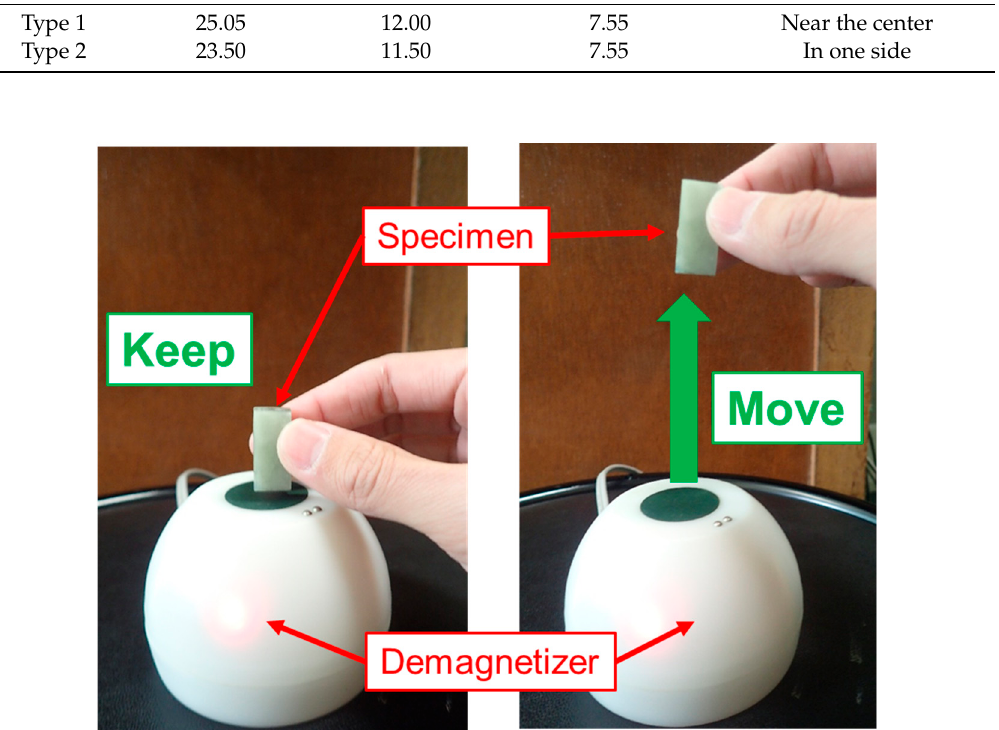
Figure 3. Demagnetizer.